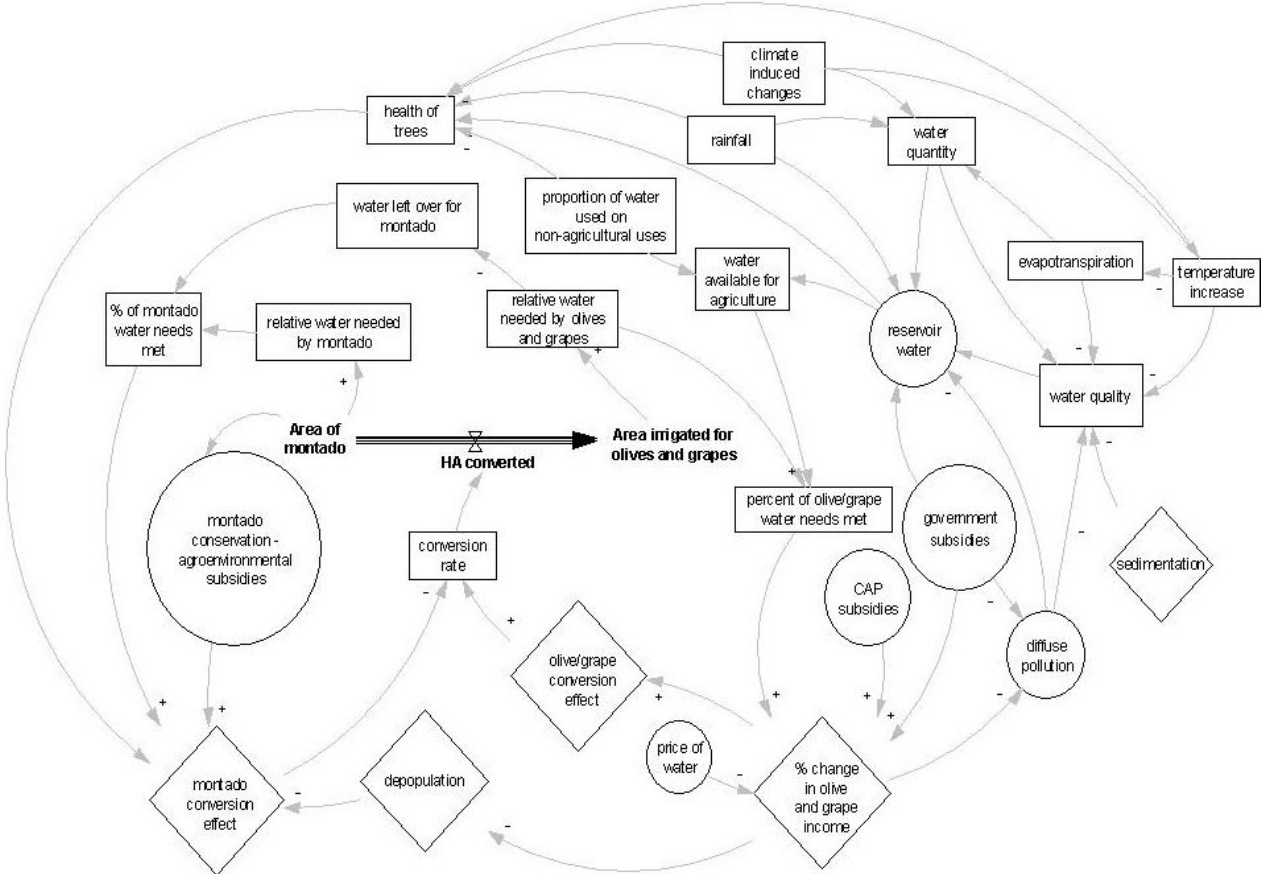
Fig. 7 . Conceptual model for the Alentejo region showing the casual loops and interlinkages that influence the rate of change of the area converted from a montado to an irrigated